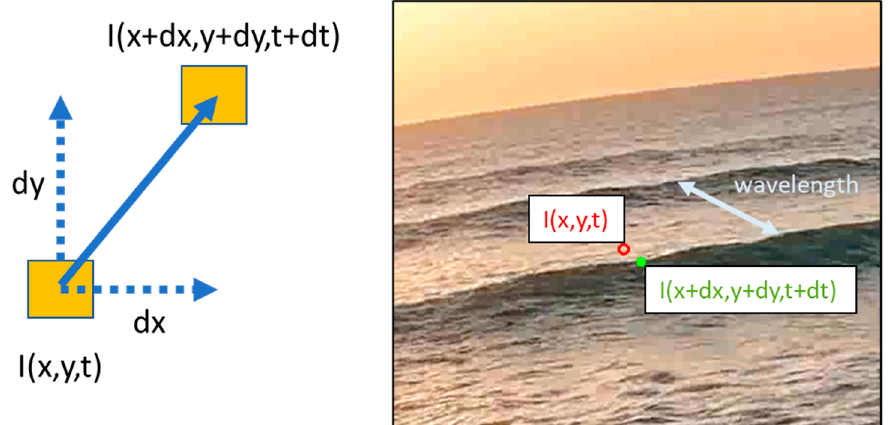
Figure 5. Motion estimation using Optical Flow on the video frames; I(x,y,t): pixel at position x,y at time t; I(x + dx,y + dy,t + dt): pixel at position x + dx,y + dy at time t + dt.